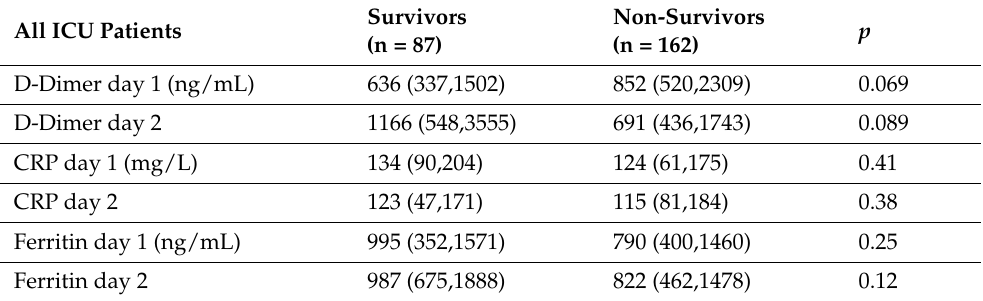
Table 11. Inflammatory and thrombotic markers in COVID-19 ICU survivors and